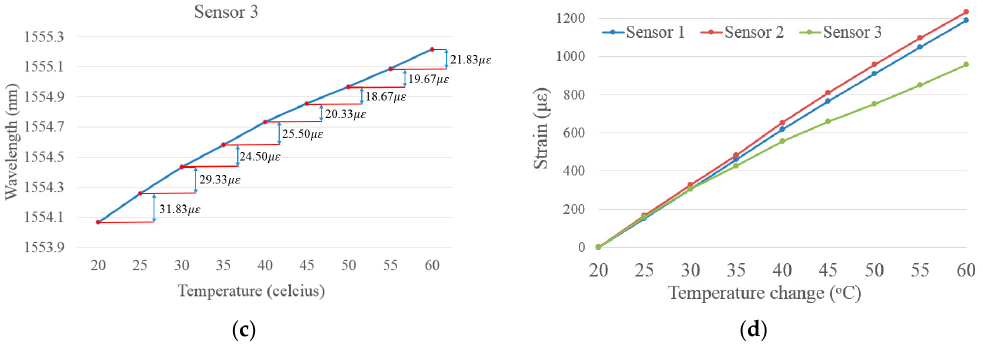
Figure 13. FBG sensors’ responses to temperature variations. ( a ) Temperature response of Sensor 1; ( b ) Temperature response of Sensor 2; ( c ) Temperature response of Sensor 3; ( d ) Comparison of the three FBG sensors.